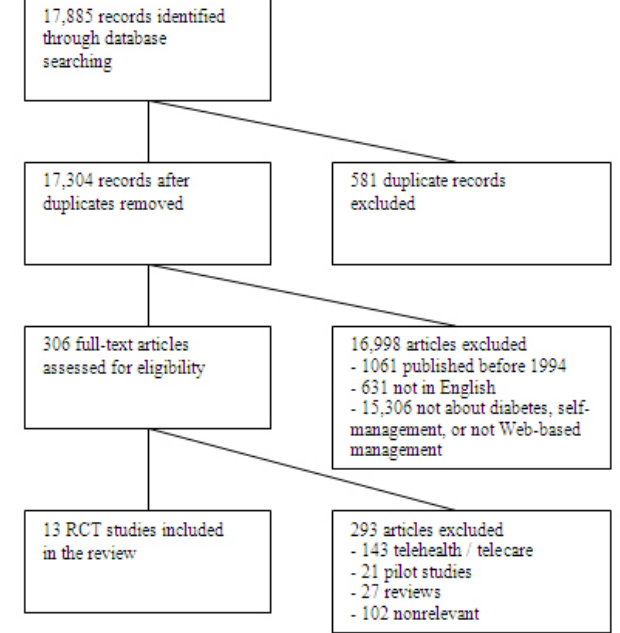
Figure 1. Flowchart screening process of articles included in